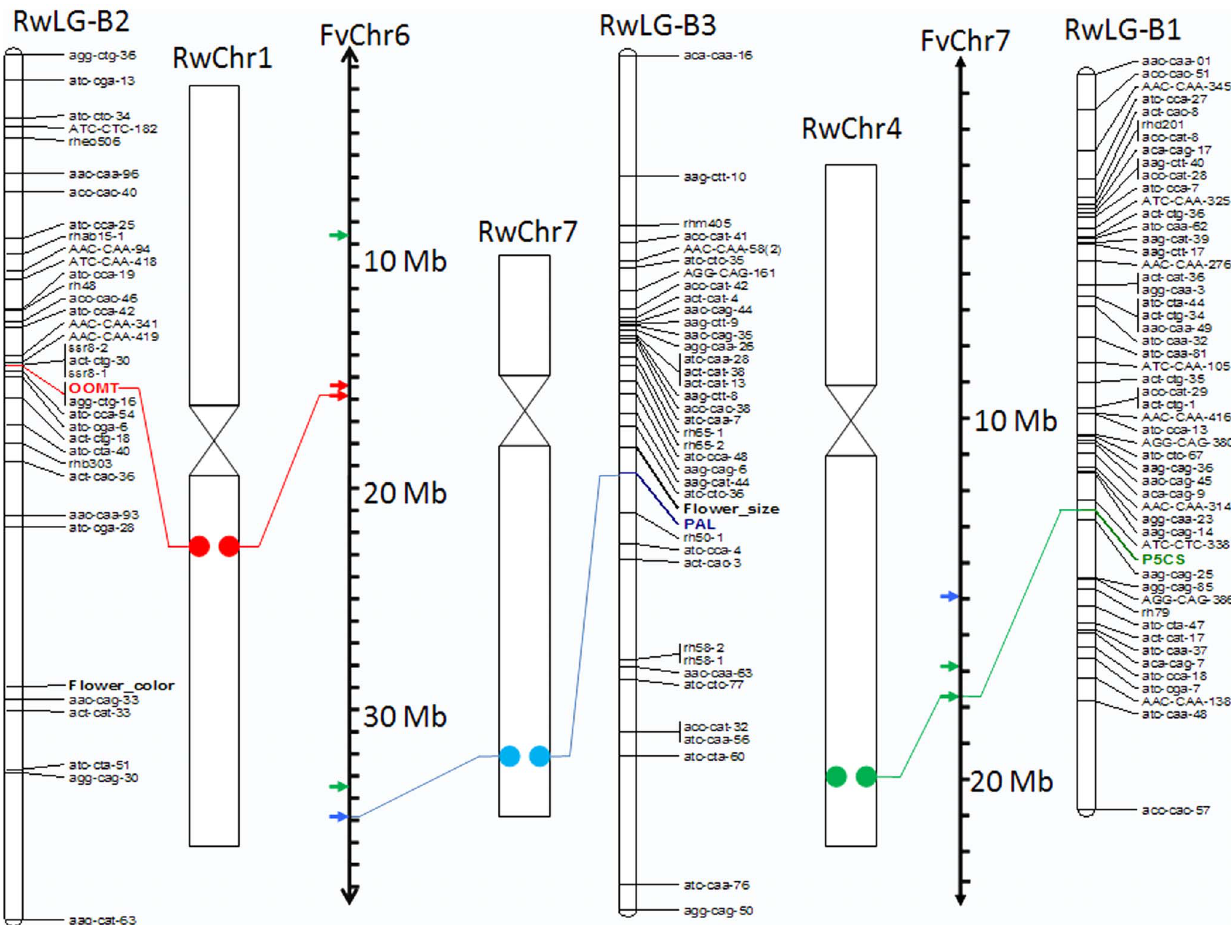
Fig. 4. Integration of the gene position on the genetic map (RwLG) (partially) obtained by regression mapping in Joinmap 4.0 showing the consensus linkage groups with indication of the map position of P5CS (green), OOMT (red), PAL (blue) and the physical chromosomes of Rosawichurana (RwChr) and the pseudochromosomes of Fragariavesca (FvChr). Framework of the genetic linkage map follows Moghaddam et al. (2012).